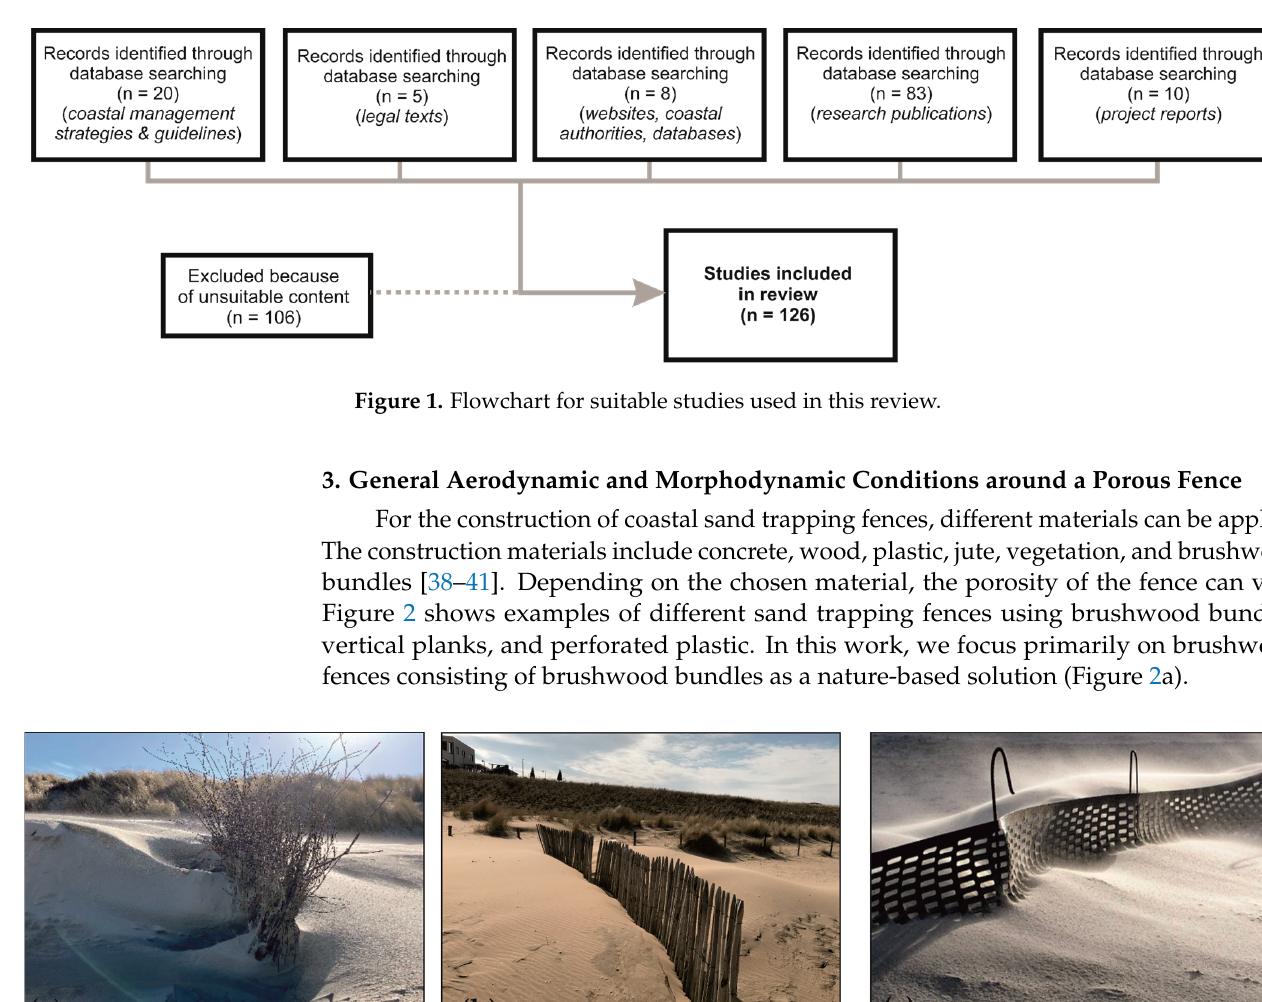
Figure 2. Examples of different design types of sand trapping fences: ( a ) brushwood, ( b ) vertical plank, ( c ) perforated plastic. Photograph in ( c ) is published with permission from Peter Tigges [42].